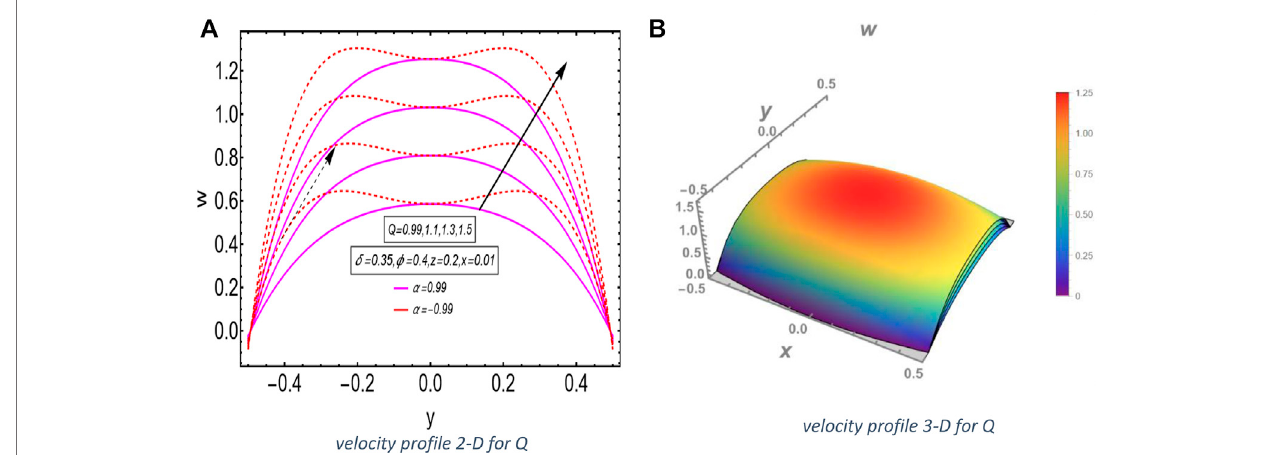
FIGURE 3 | (A) Velocity pro fi le 2-D for Q. (B) Velocity pro fi le 3-D for Q.